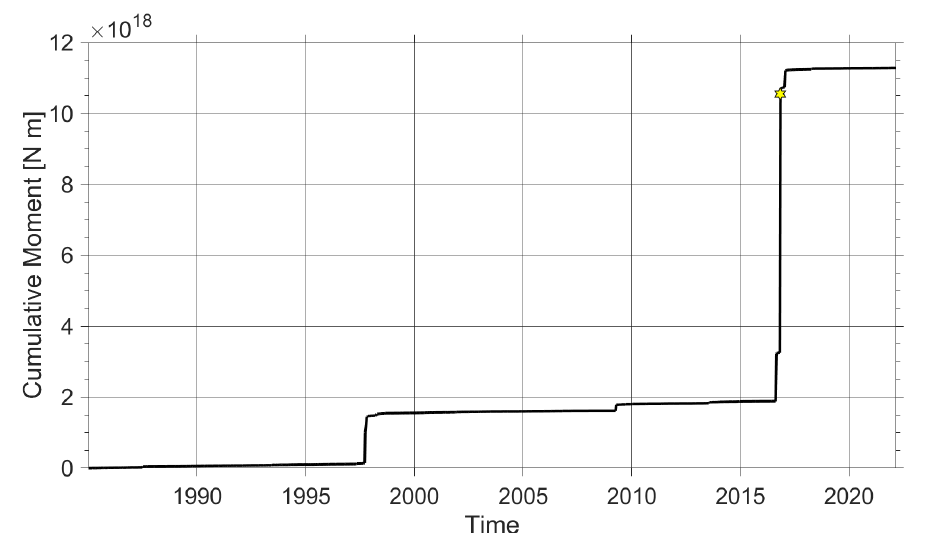
Figure 2. Representation of the cumulative moment curve in the time range from 1985 to 2022. The star represents the Norcia M6.5 earthquake, which was the strongest event of the 2016/2017 central Italy seismic